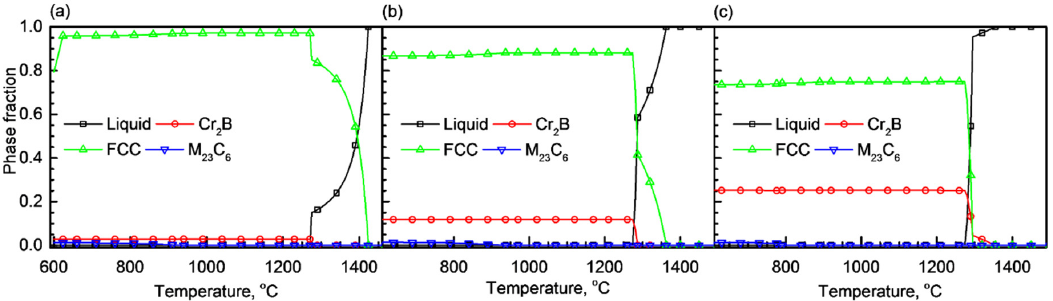
Figure 1. Equilibrium phase diagrams of ( a ) B019, ( b ) B078, and ( c ) B176 alloys calculated using Thermo ‐ Calc software.